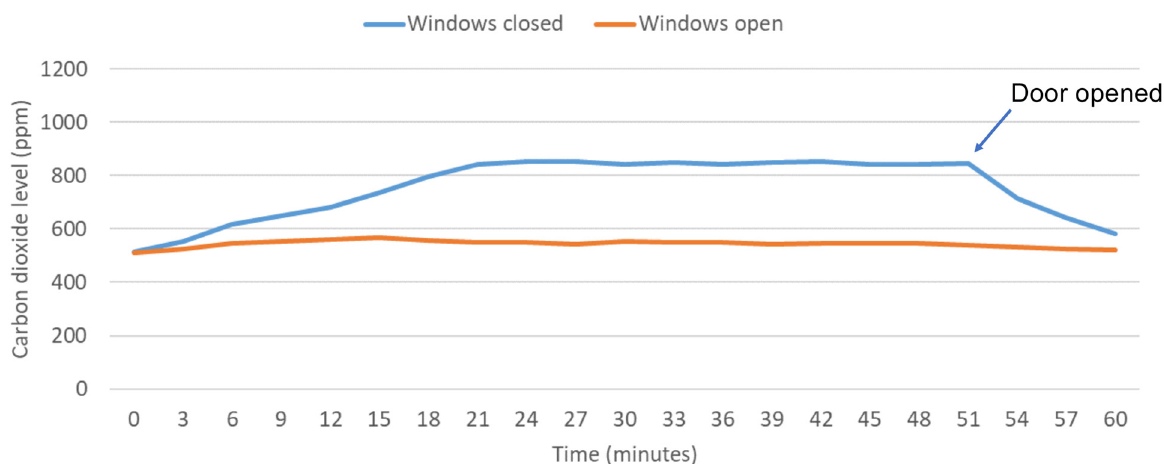
Figure 2. Study with 2 occupants. Carbon dioxide levels in parts per million (ppm) in a study (volume, 30.0 m 3 ) with 2 people present with the windows open and door closed and with the windows and door closed followed by opening the door after 50 minutes. Peak levels of carbon dioxide above 800 parts per million (ppm) were considered an indicator of suboptimal ventilation for the number of occupants